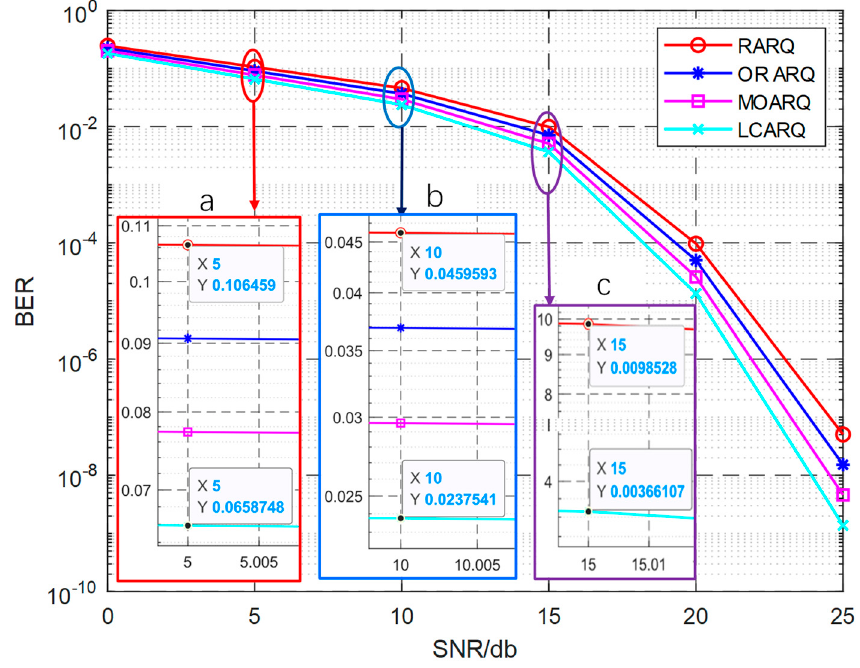
Figure 4. Simulation comparison of packet error rate and bit error rate of the two algorithms. ( a ) BER amplification comparison with SNR of 5 db. ( b ) BER amplification comparison with SNR of 10 db. ( c ) BER amplification comparison with SNR of 15 db. Another finding of the experiment is that the interference between signals is